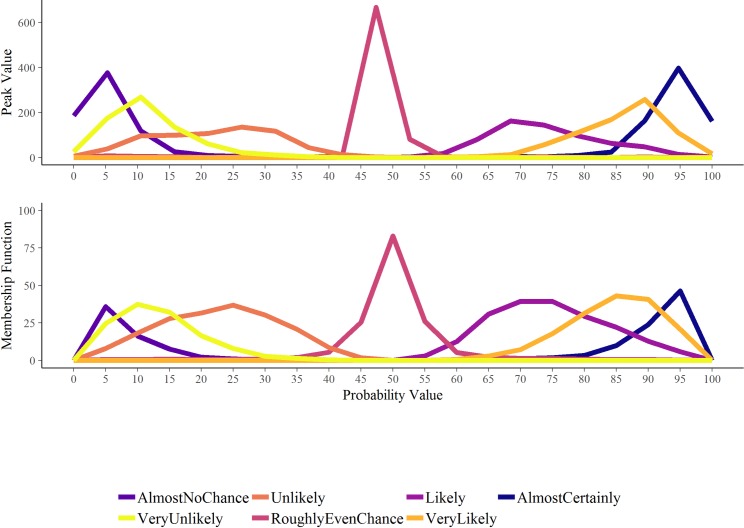
Peak value (PV) and Membership function (MF) methods for charting the frequency (PV) and probability (MF) with which different values are associated with different expressions for our participants.